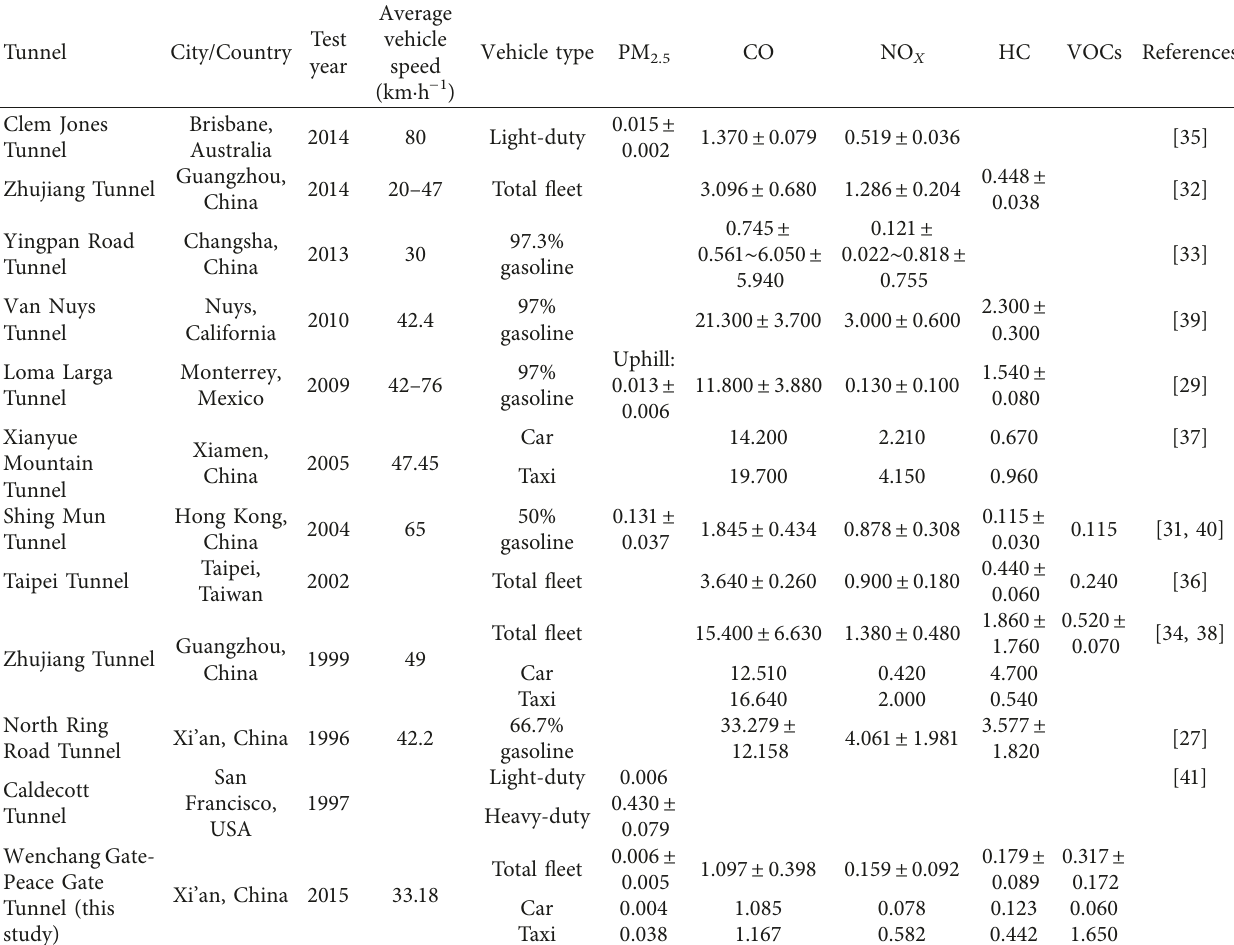
Table 4: A comparison of the EFs (g · veh − 1 · km − 1 ) among this study and other studies.